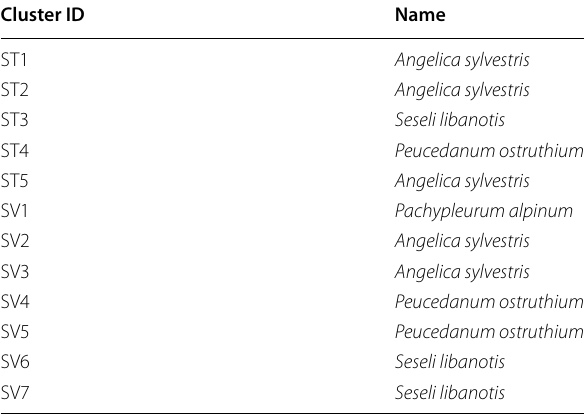
Table 6 Selinum cluster ID and names for matK Cluster